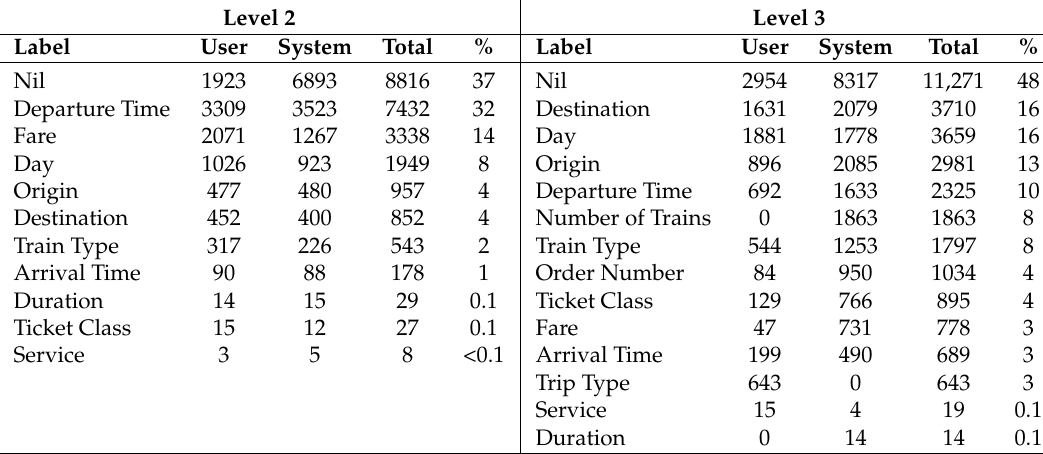
Table 4. Distribution of the domain-dependent labels of Levels 2 and 3 in the DIHANA corpus. The labels shown in this table are translations of the original labels in